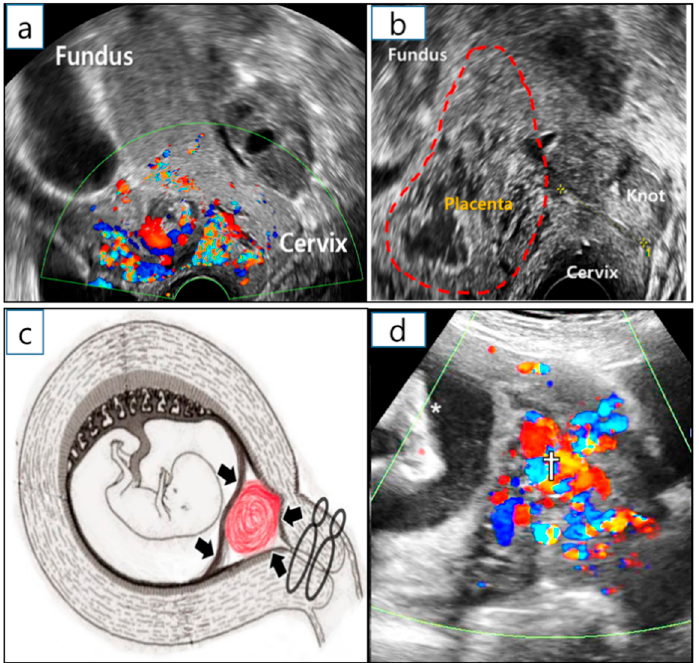
Figure 4. Management of arterio-venous malformation after selective CSP embryo reduction. ( a ) Ul- trasonography to visualize RGT with cervical shortening at 10 +3 GW before cervical cerclage. The RGT went into the uterine cervical internal os. ( b ) Transvaginal ultrasonography at 12 +3 GW after the cerclage. ( c ) Effect of cervical cerclage role on HCSP management (details are written in the discussion section). ( d ) Ultrasound examination at 24 +3 GW. Enlarged arterio-venous circulation was observed in the demised CSP (†); asterisk (*) indicates the fetal foot. CSP—cesarean scar pregnancy; GW—gestational weeks; RGT—remnant gestational